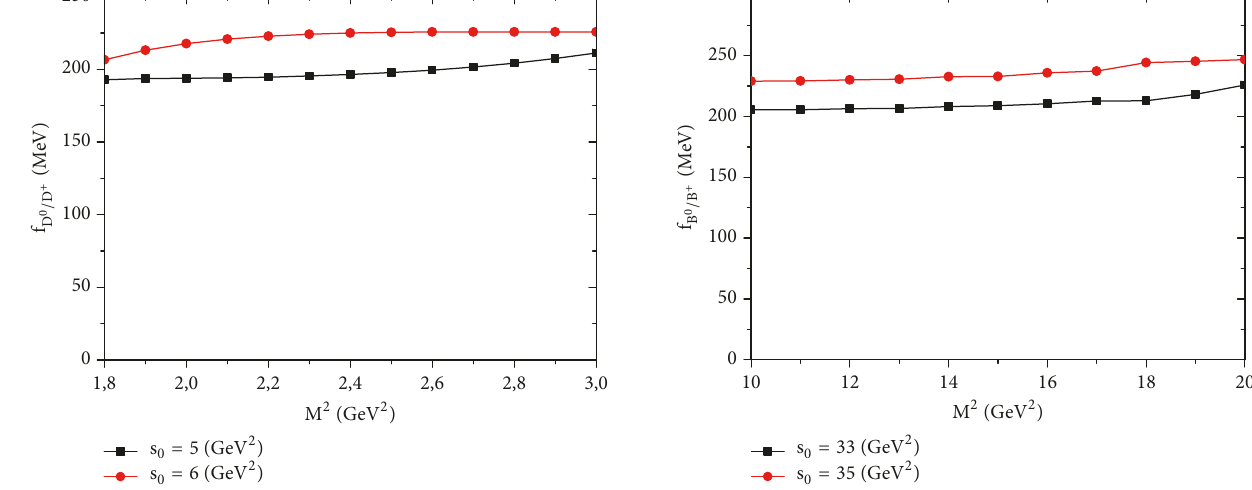
Figure 7: Borel parameter dependence of the 𝐵 + /𝐵 0 decay con- stants.